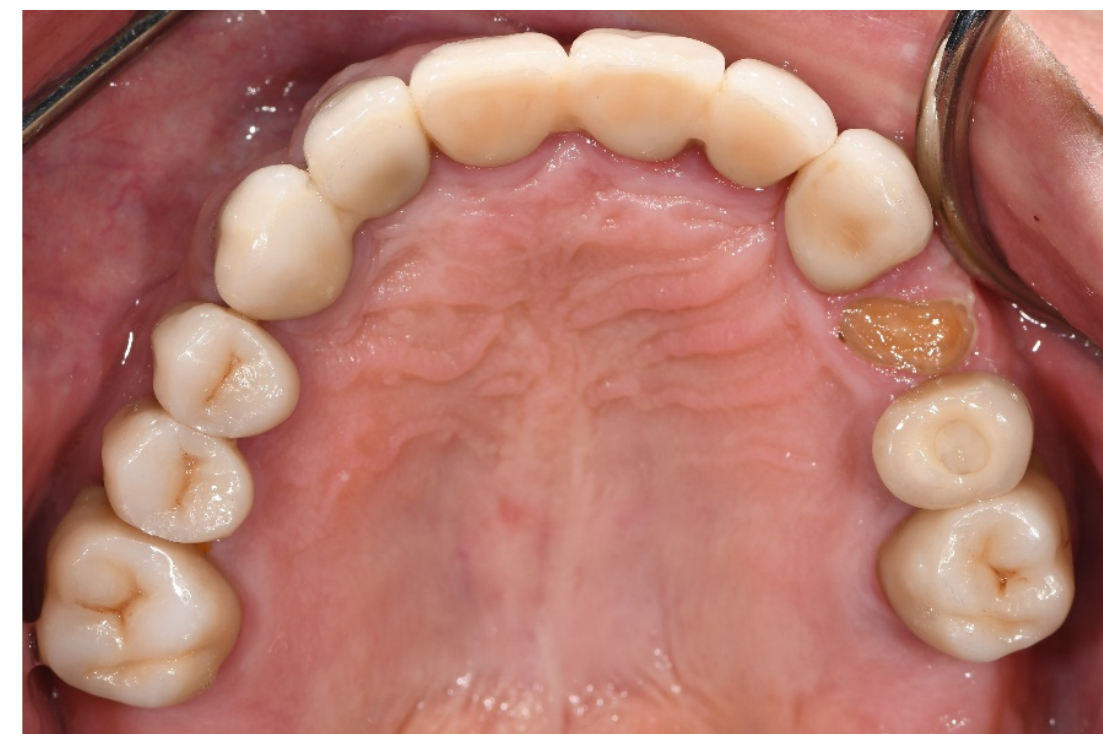
survival analyses concerning implant survival are shown in Tables 4 and 5 (bruxers and non-bruxers, respectively).